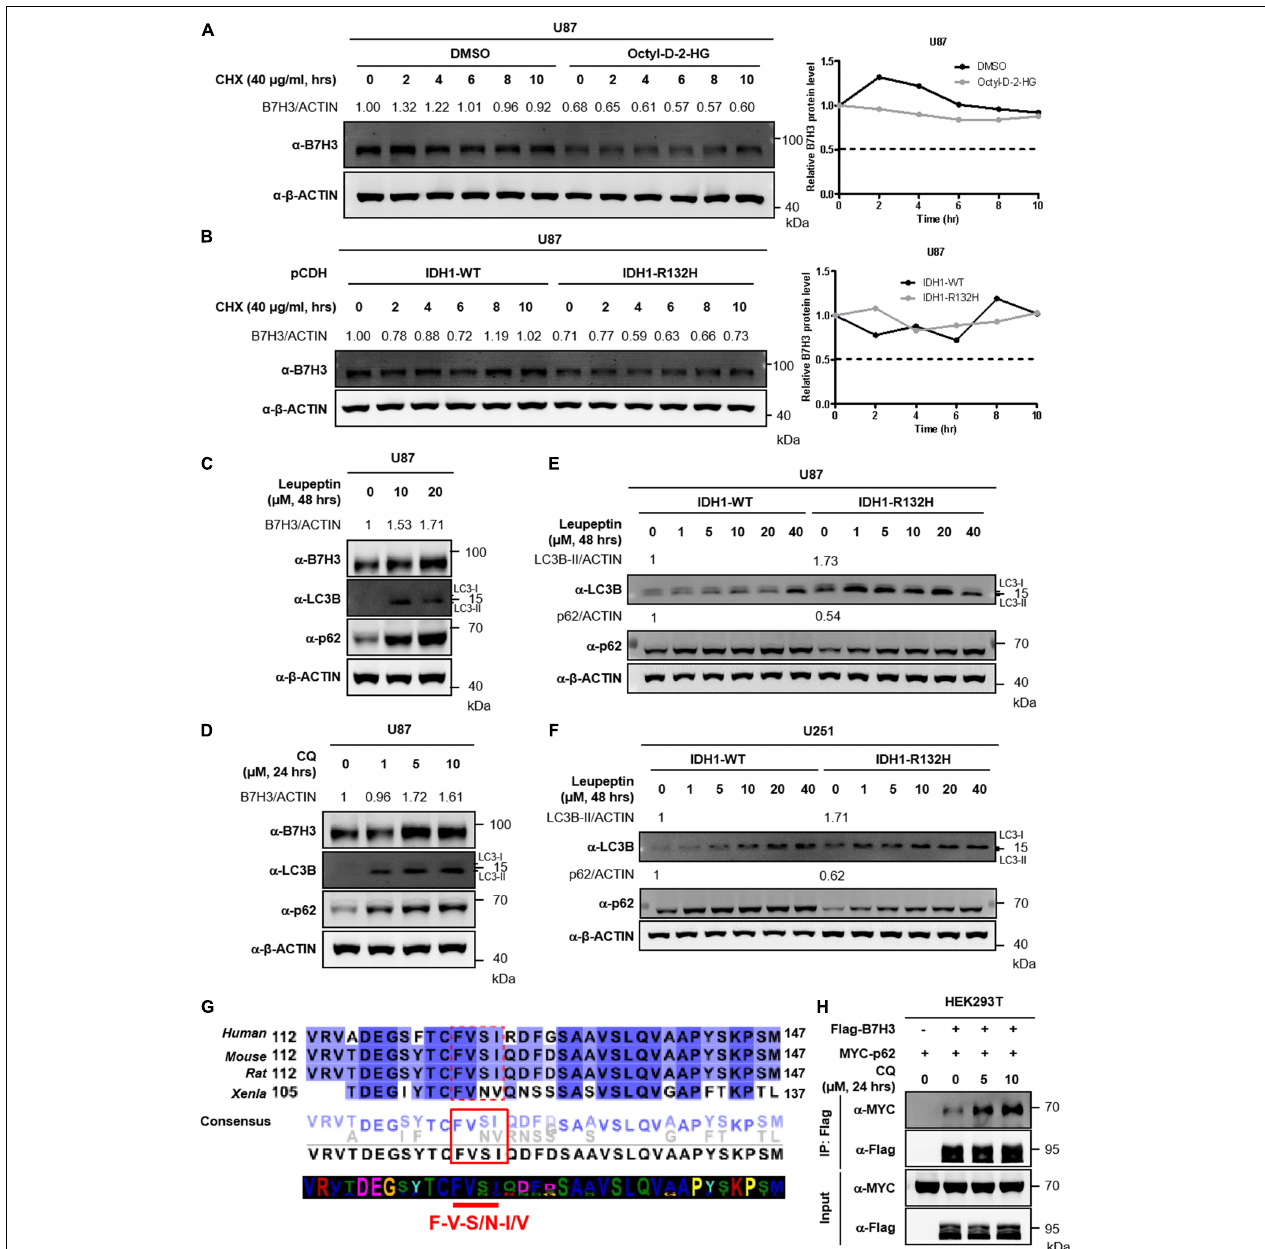
FIGURE 3 | Inhibition of autophagy blocks the degradation of B7H3. (A) B7H3 is a stable protein in U87 cells. Cells were pretreated with DMSO or cell-permeable octyl-D-2HG and then 40 µ g/mL CHX was added in the cells for the indicated time course. After cell collection, immunoblotting was performed with the indicated antibodies (left). Relative quantification of B7H3 protein level was shown on the right. (B) B7H3 is a stable protein in IDH1-WT U87 cells. Stably expressed IDH1-WT or IDH1-R132H U87 cells were treated with 40 µ g/mL CHX for the indicated time course. Immunoblotting was performed with the indicated antibodies (left). Relative quantification of B7H3 protein level was shown on the right. (C) Leupeptin treatment blocks the degradation of B7H3 in U87 cells. Cells were treated with leupeptin for the indicated concentrations and time. After cell collection, immunoblotting was performed with the indicated antibodies. (D) CQ treatment blocks the degradation of B7H3 in U87 cells. Cells were treated with CQ for the indicated concentrations and time. After cell collection, immunoblotting was performed with the indicated antibodies. (E,F) Autophagy is more active in IDH1-R132H U87 and U251 cells. Stable IDH1-WT and IDH1-R132H U87 (E) and U251 (F) cells were collected for immunoblotting with the indicated antibodies. Gradient concentrations of leupeptin treating cells for 48 h were used to verify LC3B and p62 bands. (G) B7H3 contains a potential LIR motif. B7H3 amino acid sequences in species including Homo sapiens, Mus musculus, Rattus norvegicus, and Xenopus laevis were analyzed by the online tool Jalview (http://www.jalview.org/). Dotted red box, solid red box and red straight line indicate the potential LIR sequences in B7H3. (H) CQ treatment enhances the interaction between B7H3 and p62 in HEK293T cells. HEK293T cells were seeded in the six-well plate at a density of 0.4 × 10 6 . Flag-B7H3 was co-expressed with Myc-p62 in HEK293T cells. 24 h later after plasmid transfection, CQ was added in the cells and incubated for another 24 h. Cells were lysed and proteins were immunoprecipitated with anti-Flag M2 affinity beads. Immunoblotting was performed with the indicated antibodies. All experiments were performed in triplicate and representative results were